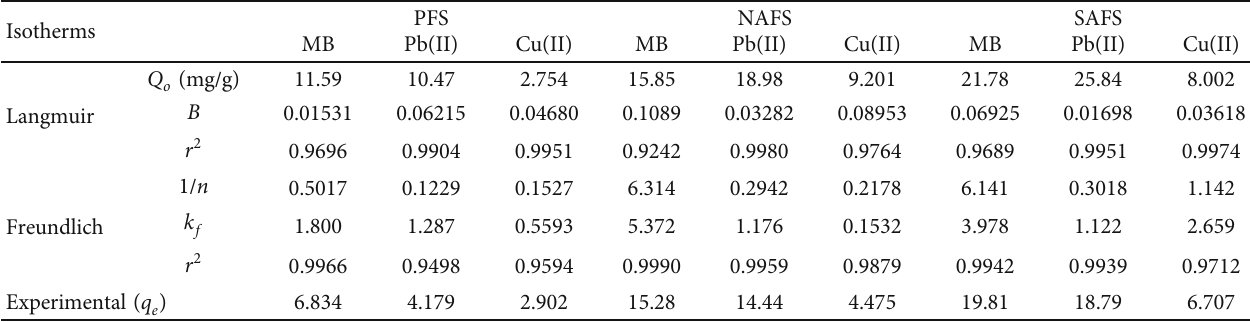
Figure 5: E ff ect of the initial concentration of Pb(II), Cu(II), and MB onto pure (a) PFS and treated (b) SAFS and (c) NAFS fennel seed adsorbents (system parameters: temperature = 298 K, pH = 7, contacttime = 120 min, andadsorbent mass = 10mg ). Table 3: Isotherm models for the adsorption of Pb(II), Cu(II), and MB onto pure (PFS) and treated (NAFS and SAFS) fennel seed